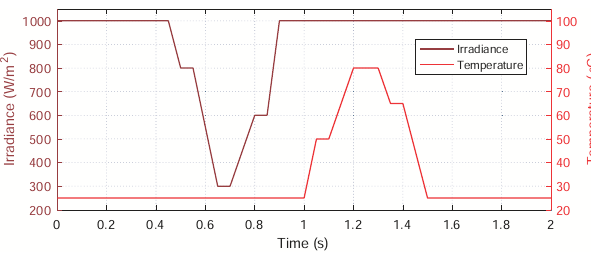
Figure 4. The curves of irradiance and